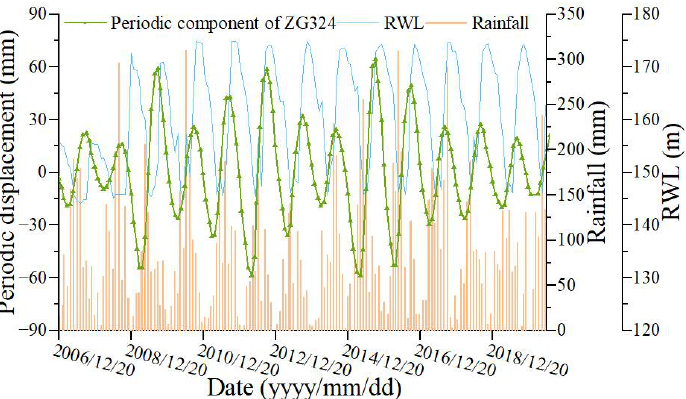
Figure 13. Relationships between the periodic displacement of ZG324, the rainfall, and the reser- water level. voir water level.